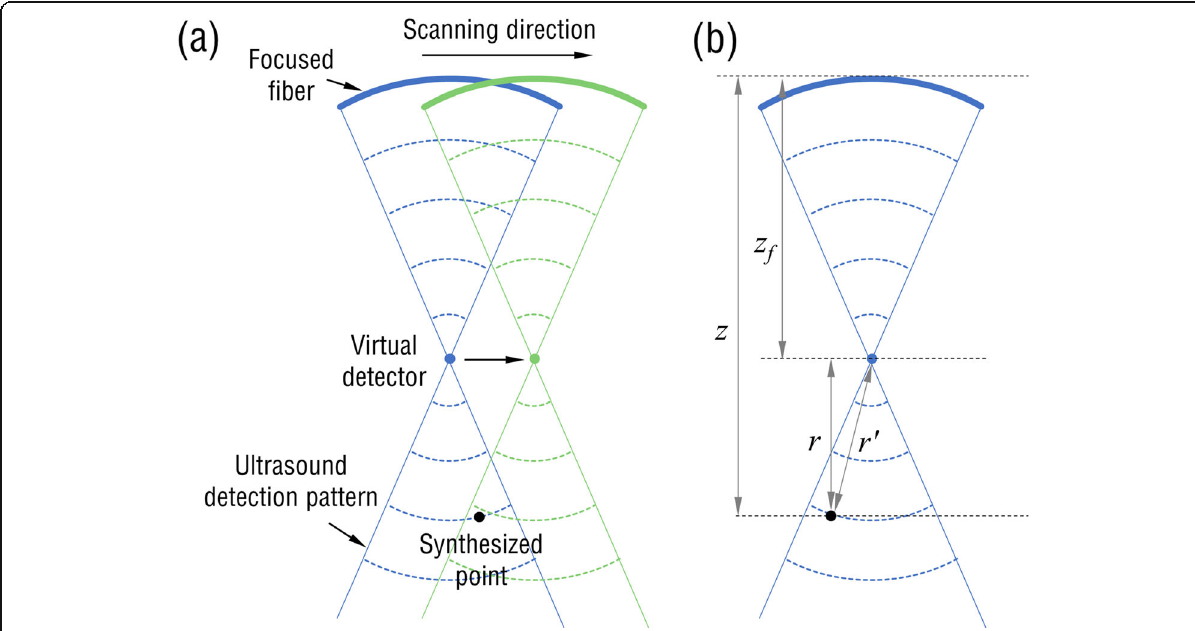
Fig. 3 a Schematic of a virtual point detector for SAFT. b Focusing geometry for the SAFT to calculate the time delay Δ t